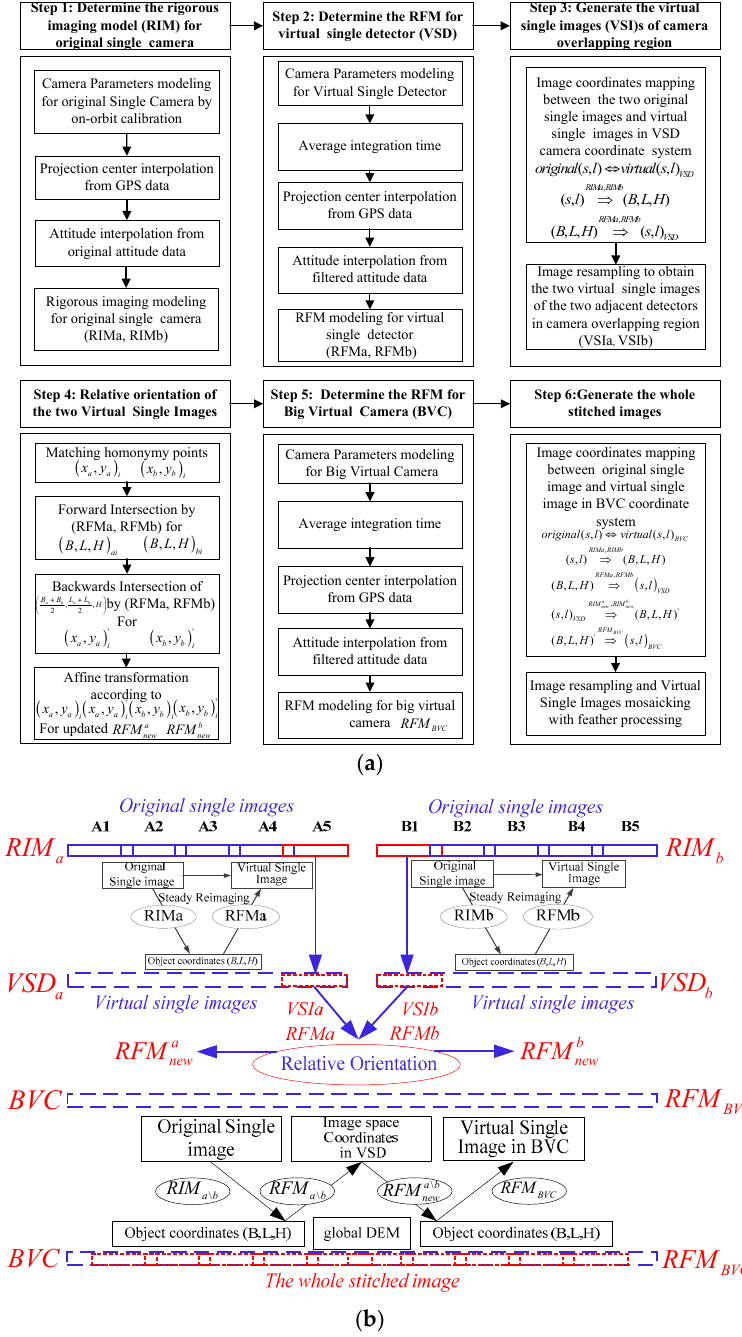
Figure 2. The image mosaic workflow based on the virtual single detector and the big virtual camera: ( a ) Flow diagram; ( b ) Schematic diagram. Step 1: Determine the rigorous imaging model (RIM) for the original single camera. The RIM for the double-cameras can be constructed based on the collinearity condition equation. and b